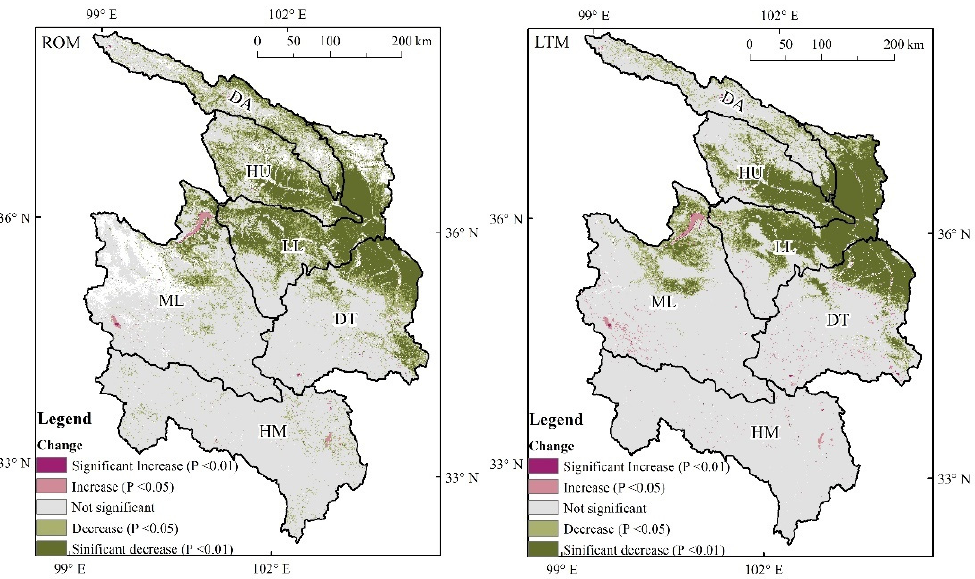
Figure 10. Spatial distribution of water conservation change calculated by two methods.